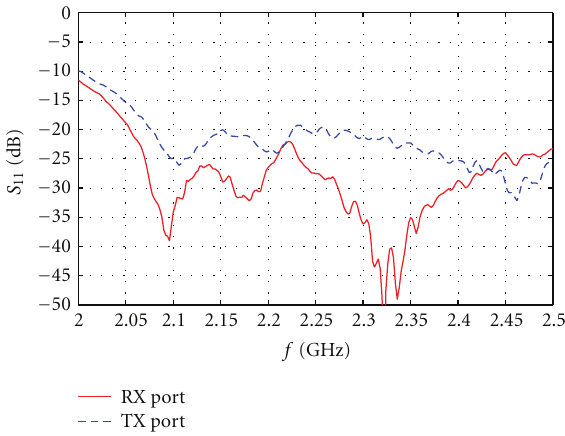
Figure 13: Measured return loss for the 2320MHz section.